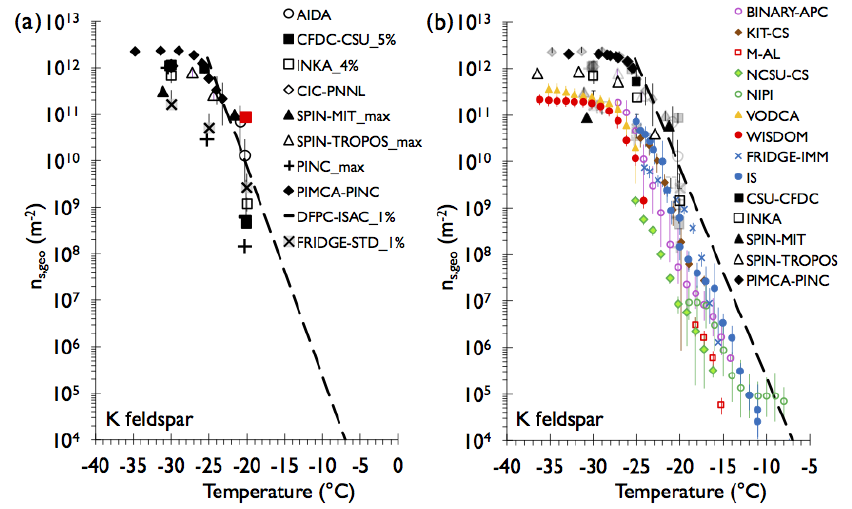
Figure 11. As in Fig. 9, but for K-feldspar aerosols sampled from the AIDA chamber prior to expansion-cooling experiments 8 (18 March 2015), 11 (20 March 2015), and 14 (23 March 2015) for panel (a) , and overlay of data from APC experiments 13 and 14 on 19 March 2015 (Fig. 6) in panel (b) . The K-feldspar fit from Atkinson et al. (2013) is shown for comparison, after conversion from n s , BET to n s , geo , as described in the text. The experiment represented by the red data point in panel (a) from the CFDC-CSU instrument is discussed in Sect. S1.2 in relation to experimental detection